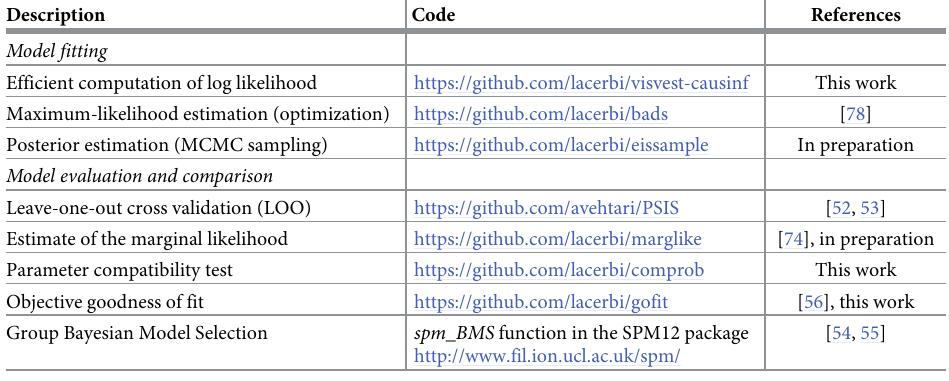
Table 3. List of algorithms and computational